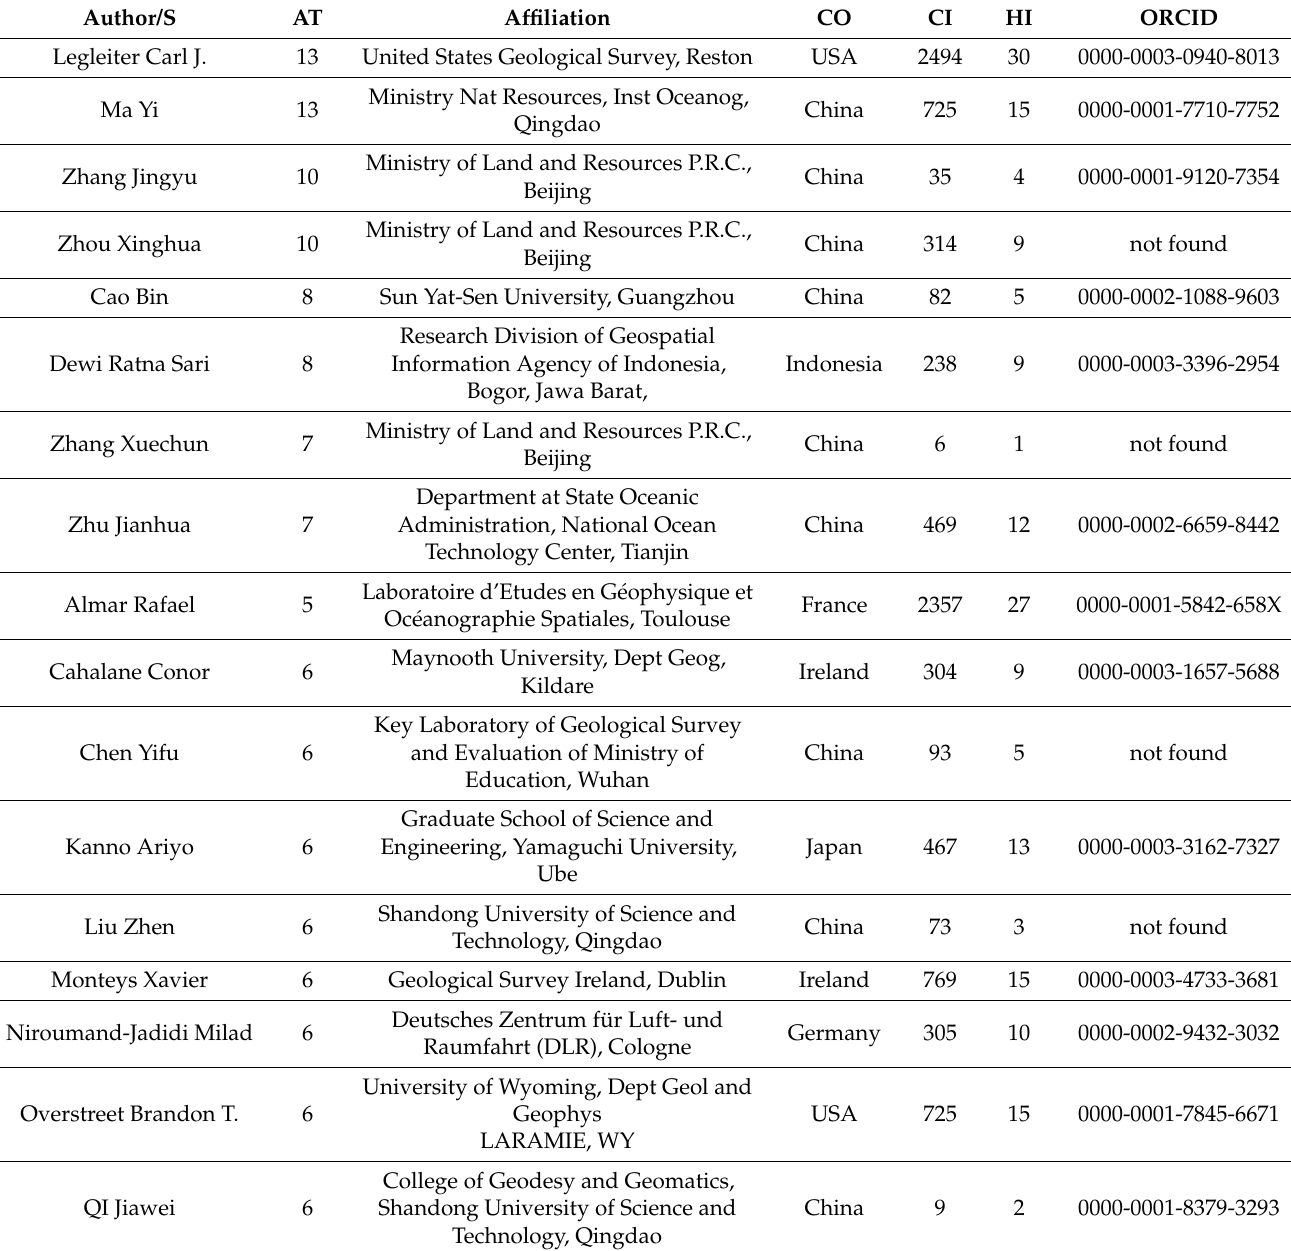
Table 4. Authors with six and more publications related to SDB (WoSCC and Scopus